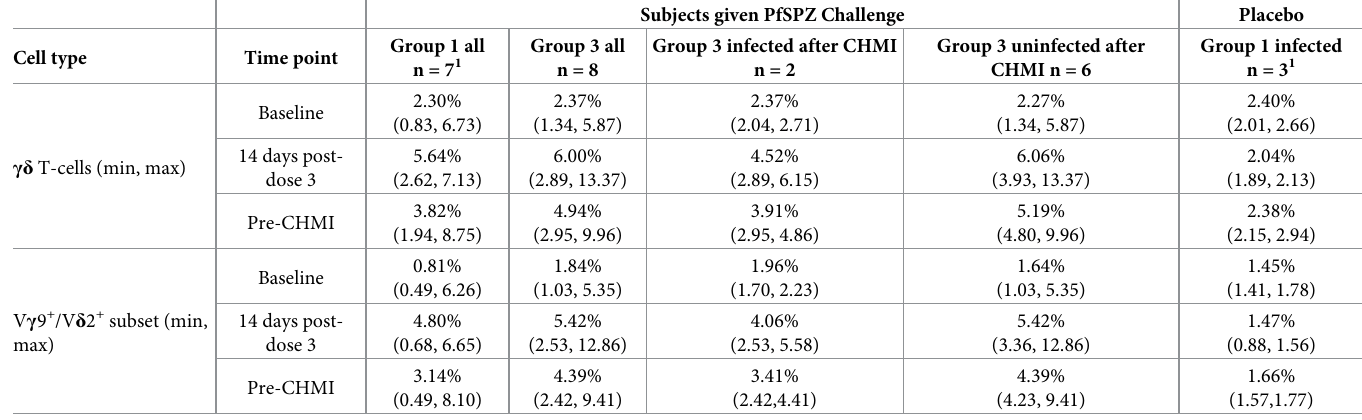
Table 3. Median percent γδ T cells of total lymphocytes and of V γ 9+/V δ 2+subset of total lymphocytes by time point, Group, and CHMI infection status. Subjects given PfSPZ Challenge